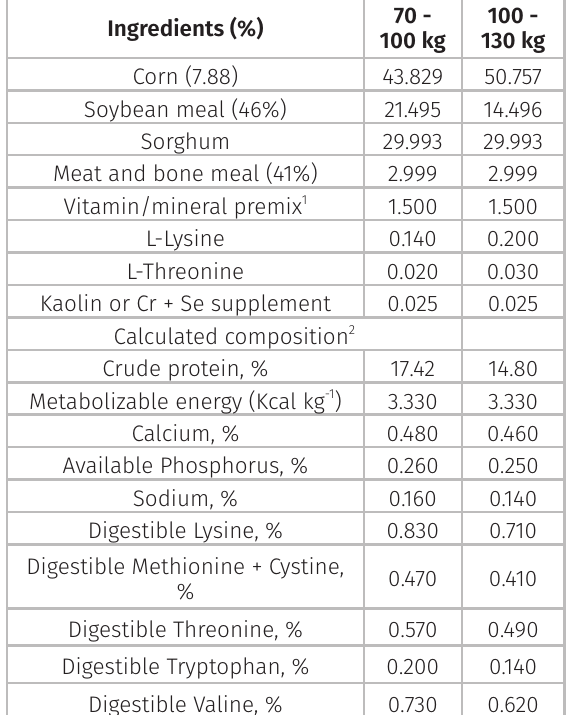
Table I. Composition of the experimental diets. Ingredients